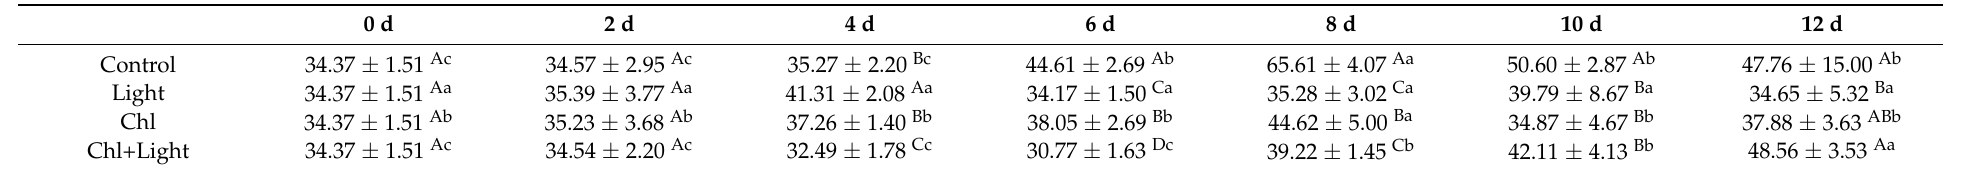
Table 3. The b* value of samples during